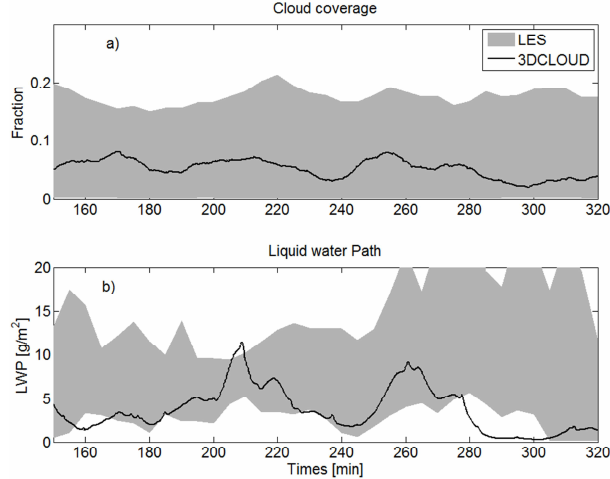
Figure 4. Time series of (a) the cloud coverage and (b) the liquid water path. The BOMEX case is displayed. The solid lines indicate 3DCLOUD results. The light shading delimits the maximum and minimum values within the master ensemble at any given time.